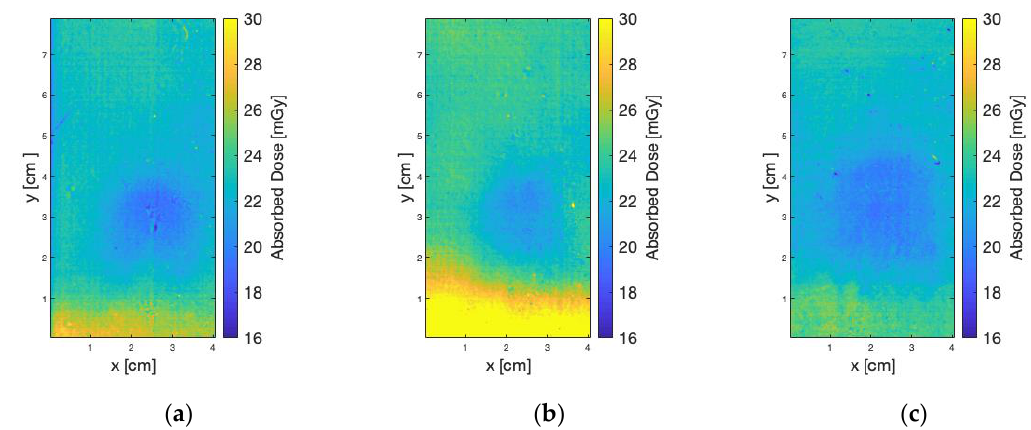
Figure 5. Film dose responses (mGy) in color wash: ( a ) 2D-dose distribution in the spinal cord region for the 17th slab; ( b ) 2D-dose distribution in the spinal cord region for the 18th slab; ( c ) 2D-dose distribution in the spinal cord region for the 19th slab.